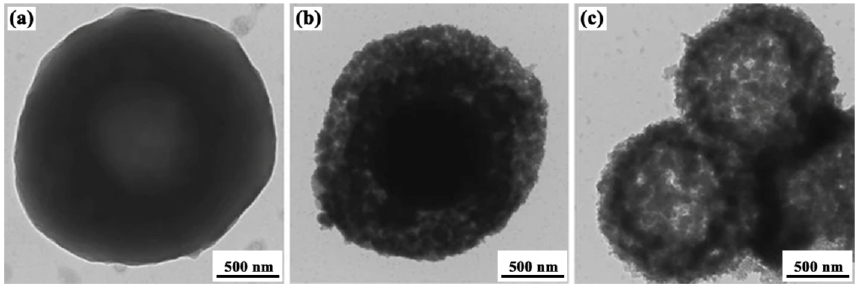
Figure 7. TEM images of ( a ) PSS particle, ( b ) composite particle, and ( c ) SiO 2 microcapsules in samples of 8 h sulfonation. Reproduced from [58] with permission from the Springer